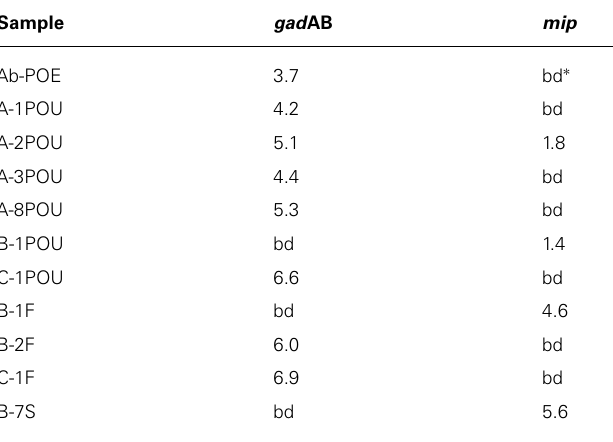
Table 2 | Log copies of E. coli ( gad AB) and L. pneumophila ( mip ) specific genes per milliliter (POE and POU’s), swab (F’s), or gram soil